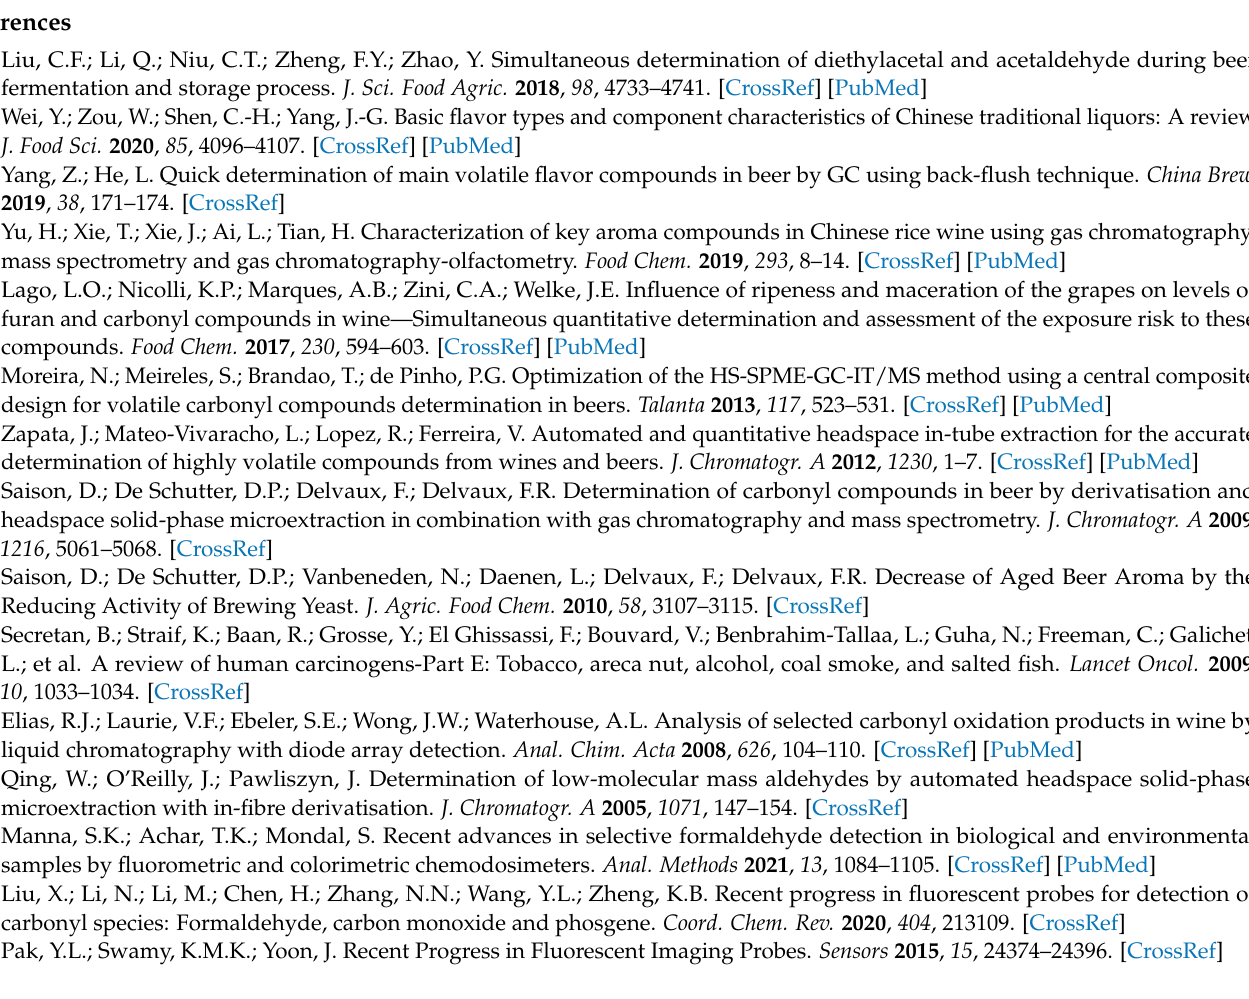
Figure S4: Job’s Plot obtained from fluorescence intensity of FPN1 and acetaldehyde. Figure S5: Sensing mechanism of FPN1 to acetaldehyde. Figure S6: The calibration curve of fluorescence intensity with the concentration of acetaldehyde. Figure S7: Consistency test of the fluorescence sensing method with BRM and GC method based on